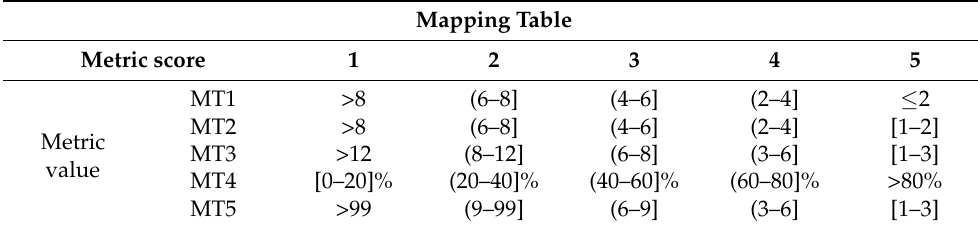
Table 3. Scoring mapping table for ontology-evaluation metrics as defined in the OQuaRE framework.